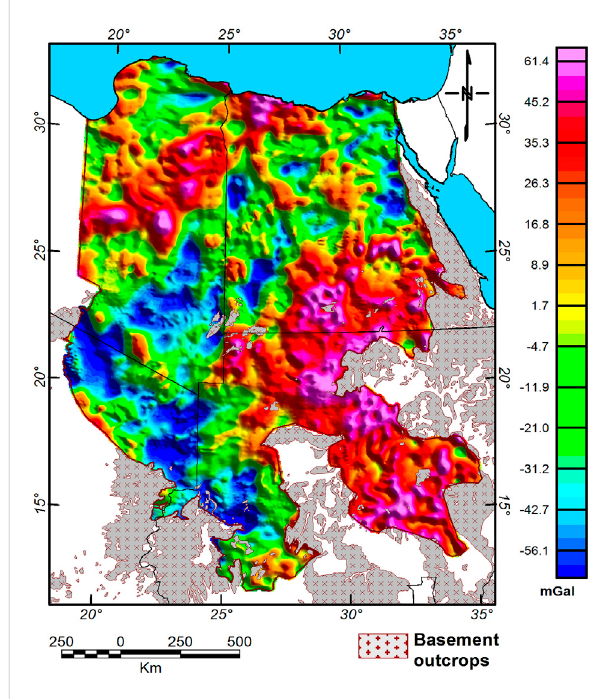
FIGURE 4 Regional gravity anomaly map (Upward contiuation: 5 km) of the high-pass fi ltered bouguer gravity map shown in Figure 3.